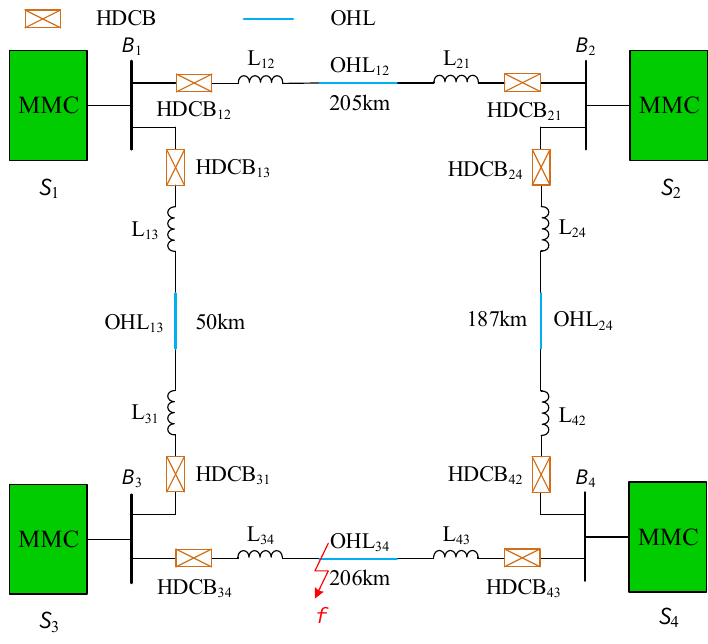
Figure 9. A ± 500 kV four-terminal VSC-based DC Figure 9. A ±500 kV four ‐ terminal VSC ‐ based DC grid.